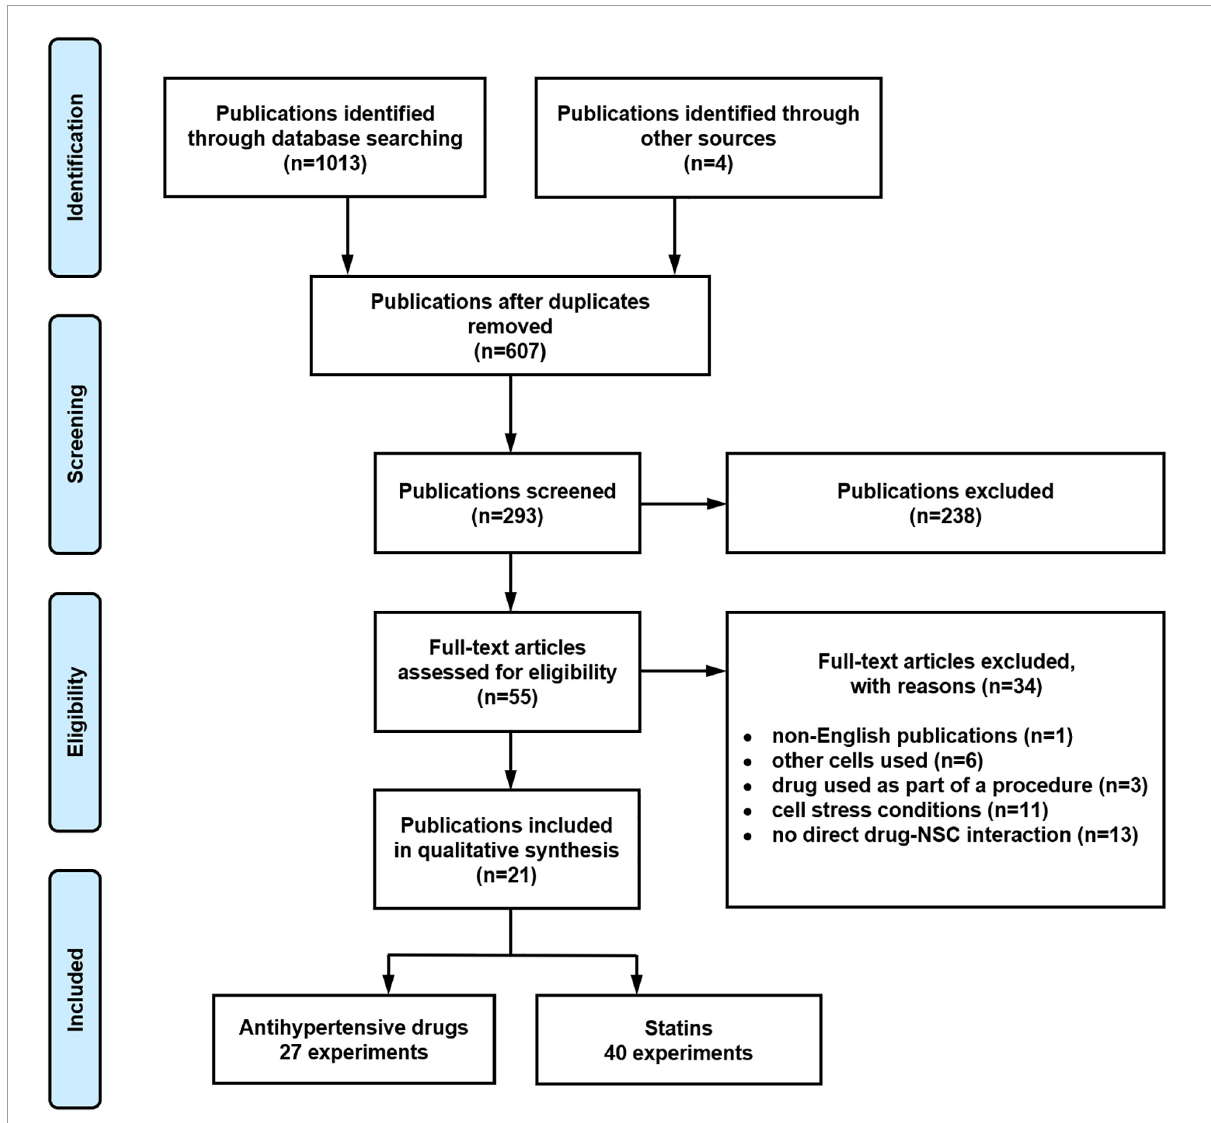
FIGURE1 Systematic literature search flow diagram illustrating the results reported according to the Preferred Reporting Items for Systematic reviews and Meta-Analyses (PRISMA)